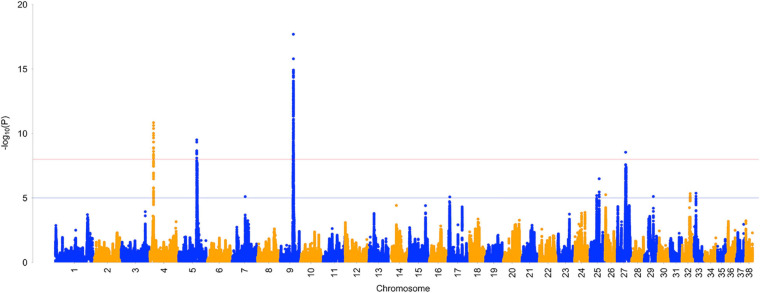
Manhattan plot of –log10
P-values from selection signature analysis using the XP-EHH test between ACL rupture case and control populations in the Labrador Retriever model. The red line denotes genome-wide significance (P < 1E-08). The blue line denotes suggestive significance (P < 1E-05).